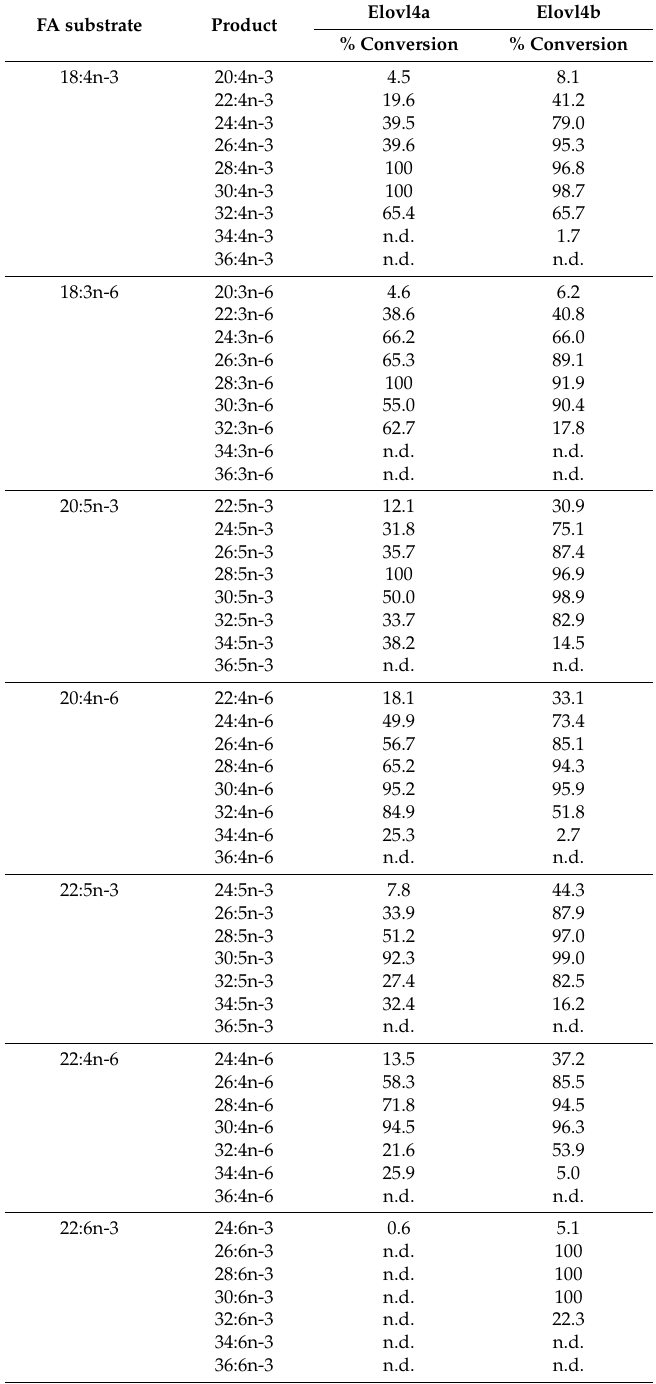
Table 4. Functional characterization of the Solea senegalensis Elovl4a and Elovl4b elongases by heterologous expression in the yeast Saccharomyces cerevisiae